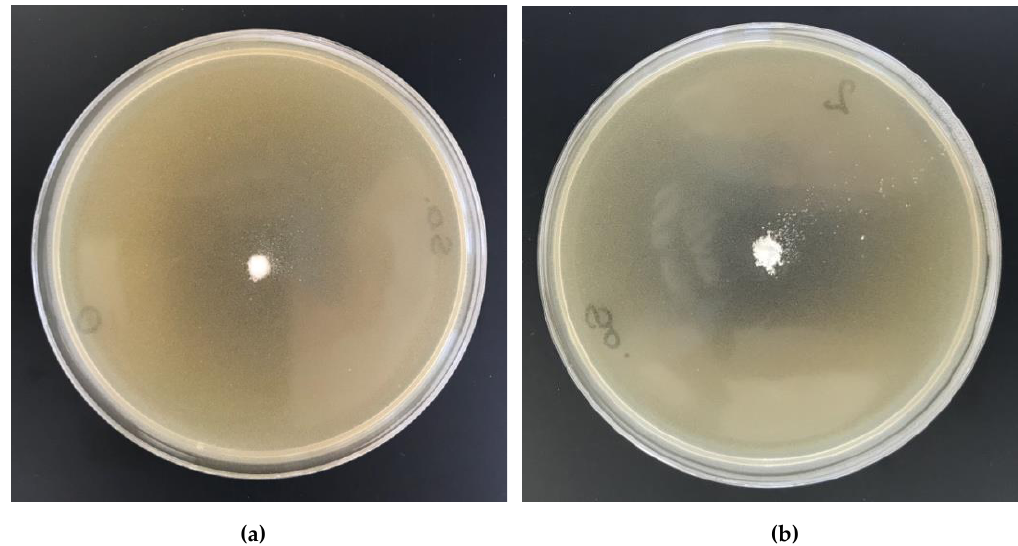
Figure 18. The Cell- O 6 -P(O)(O − )-H × Cu 2+ complexes antimicrobial activity tests against Staphylococcus aureus . Inhibition zones of bacterial growth on Petri dishes: ( a ) Cell- O 6 -P(O)(OH)-H(48 h), ( b ) Cell- O 6 -P(O)(OH)-H(48 h) × Cu 2+ .